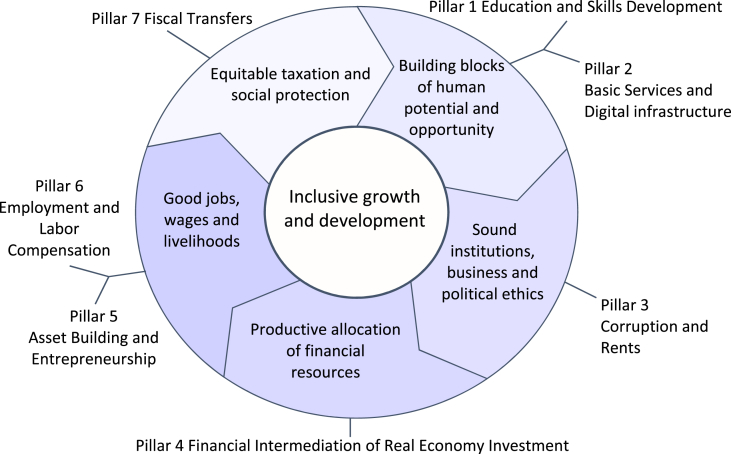
Inclusive growth and development circle [3].